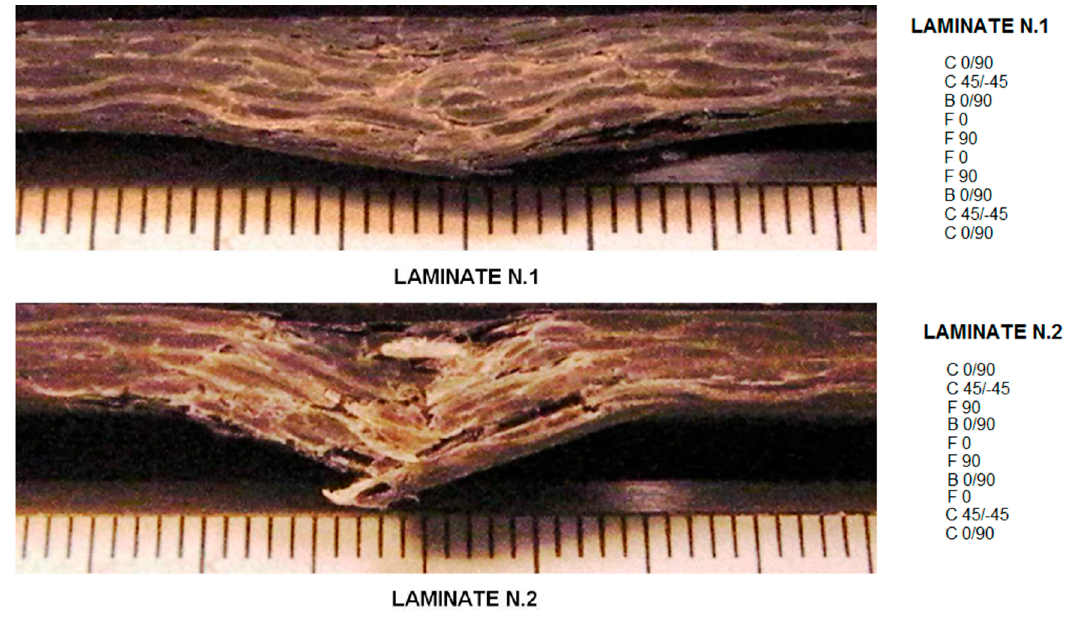
Figure 2. The impact damage at 38.4 Joules on two different configurations of carbon/basalt/flax fiber hybrid laminate [27]. (Reproduction permission obtained).